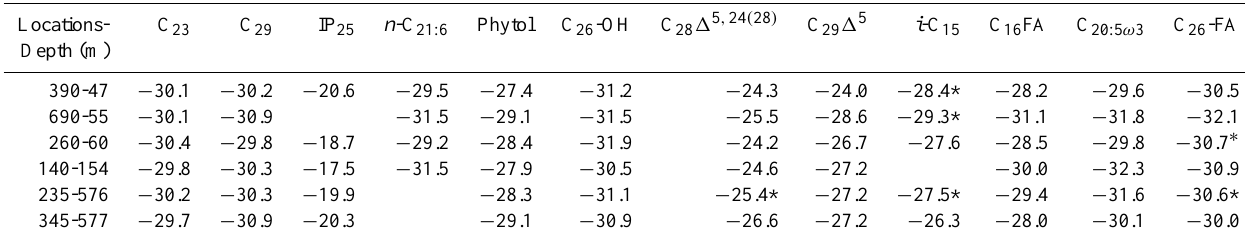
Table 12. Stable carbon isotopic composition ( δ 13 C (‰) average of three replicate injections with S.D. < 0.8) of selected lipid biomarkers in sediments from Beaufort